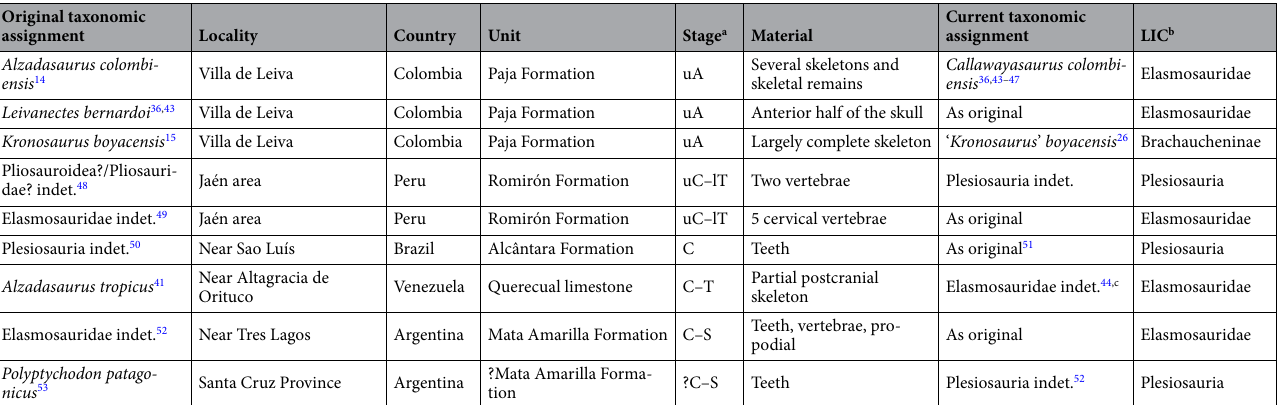
Table 1. Locality information and literature references on the mid-Cretaceous plesiosaurs of South America. Welles 14,44 , Hampe 15 , Páramo-Fonseca et al. 26,36,43 , Colbert 41 , Carpenter 45 , Jaillard et al. 49 , Carvalho et al. 50 , O’Gorman and Varela 52 , Ameghino 53 , Jaimes and Parra 46 , Goñi and Gasparini 47 , Bôas and Carvalho 51 , Meza- Velez and O’Gorman 48 . Note that Pliosauroidea?/Pliosauridae? indet. of 48 may represent the same material as that of 49 . a A Aptian, C Cenomanian, T Turonian, l lower, u upper. b Least inclusive clade. c This